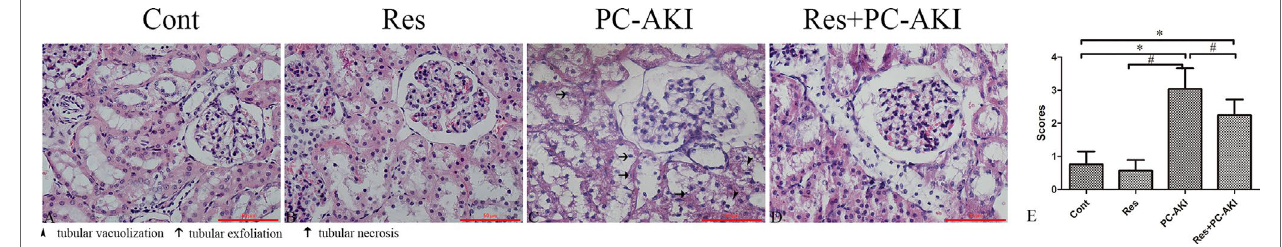
FIGURE 4 | Representative photomicrographs of HE-stained kidney sections in rabbits with different treatments. Iohexol induced obvious morphological alterations in kidneys of rabbits in the PC–AKI group. Resveratrol reduced contrast medium–induced morphological changes in the Res+PC–AKI group. (A) Cont group, (B) Res group, (C) PC–AKI group, and (D) Res+PC–AKI group. (E) Renal injury scores. Original magnifications: ×400. * P < 0.05 vs. Cont; # P < 0.05 vs. PC–AKI. Cont, control; Res, resveratrol; PC–AKI, post-contrast acute kidney injury; HE, hematoxylin and eosin.